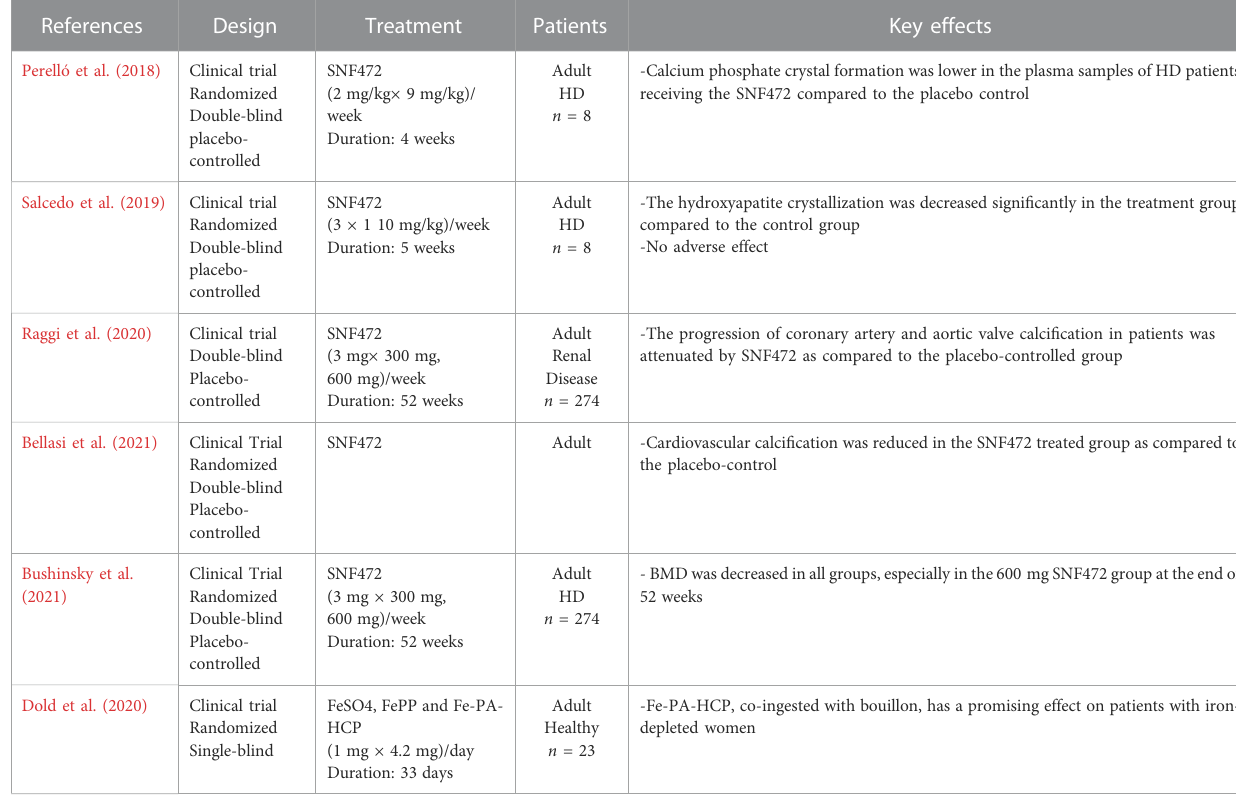
TABLE 2 Clinical trials with an arti fi cial form of the phytate in the last 5